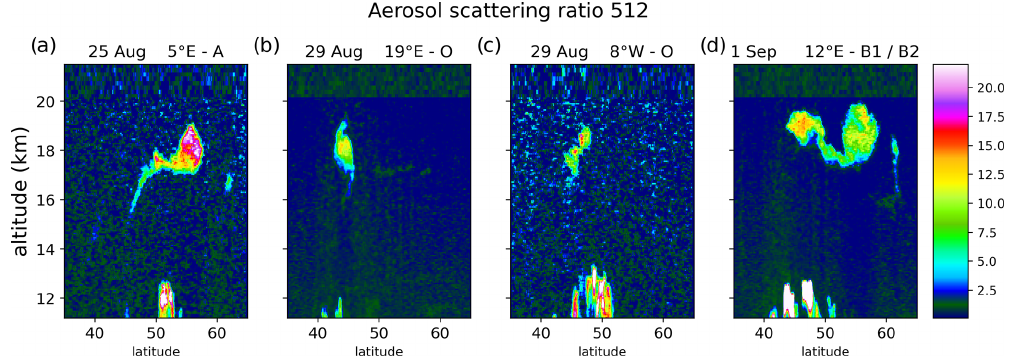
Figure 4. Selection of four CALIOP scattering ratio sections of the smoke bubbles along the orbits shown in green in Fig. 3: (a) daytime section of bubble A on 25 August, (b) east night-time and (c) west daytime sections of elongated bubble O on 29 August, and (d) night-time double section of bubbles B1 (at ∼ 55 ◦ N) and B2 (at ∼ 45 ◦ N) on 1 September.